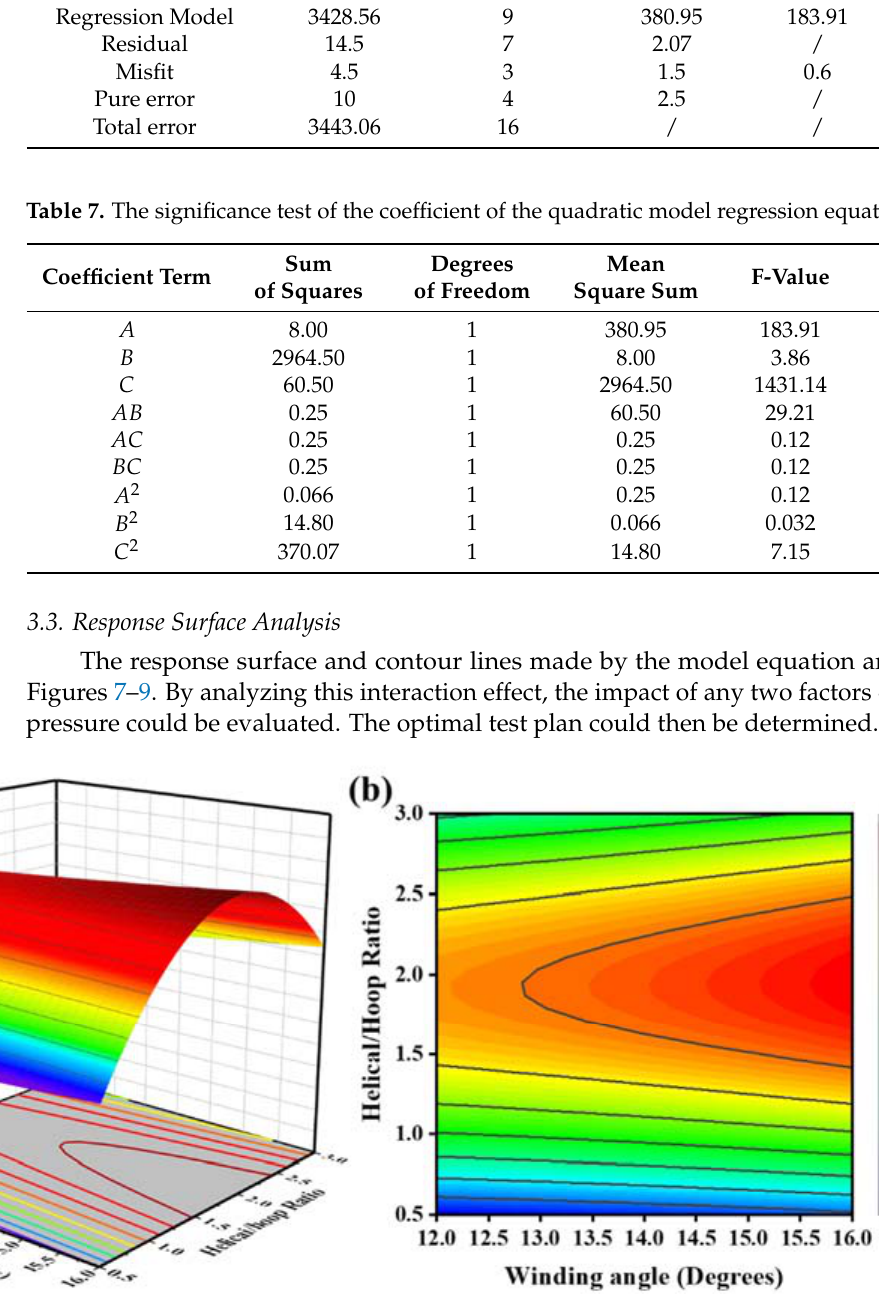
Figure 8. ( a ) Response surfaces of the effect of the helical/hoop ratio and the number of layers on blasting pressure; ( b ) contour plot of the effect of the helical/hoop ratio and the number of layers on blasting pressure. Figure 9. ( a ) Response surfaces of the effect of the winding angle and the number of layers on the blasting pressure; ( b ) contour plot of the effect of the winding angle and the number of layers on blasting pressure. Figure 7 shows the interactive effects of the winding angle and the helical/hoop ratio on the burst pressure when the number of layers was 120. Under the condition of a